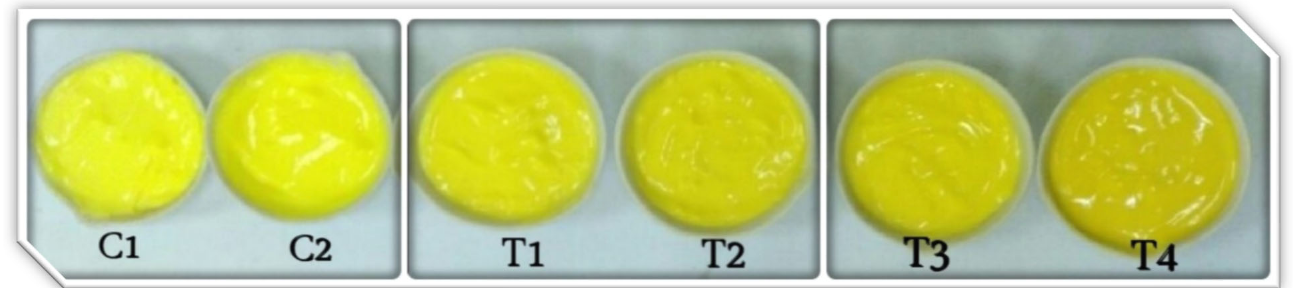
Figure 4. The photographs of control and RCFE-enriched mayonnaise samples. C1, mayonnaise with no antioxidants; C2, mayonnaise treated by 0.02% BHT; T1, T2, T3, T4: mayonnaise treated by 0.125, 0.25, 0.5, and 0.75% ethanolic Rosa canina extract, respectively.